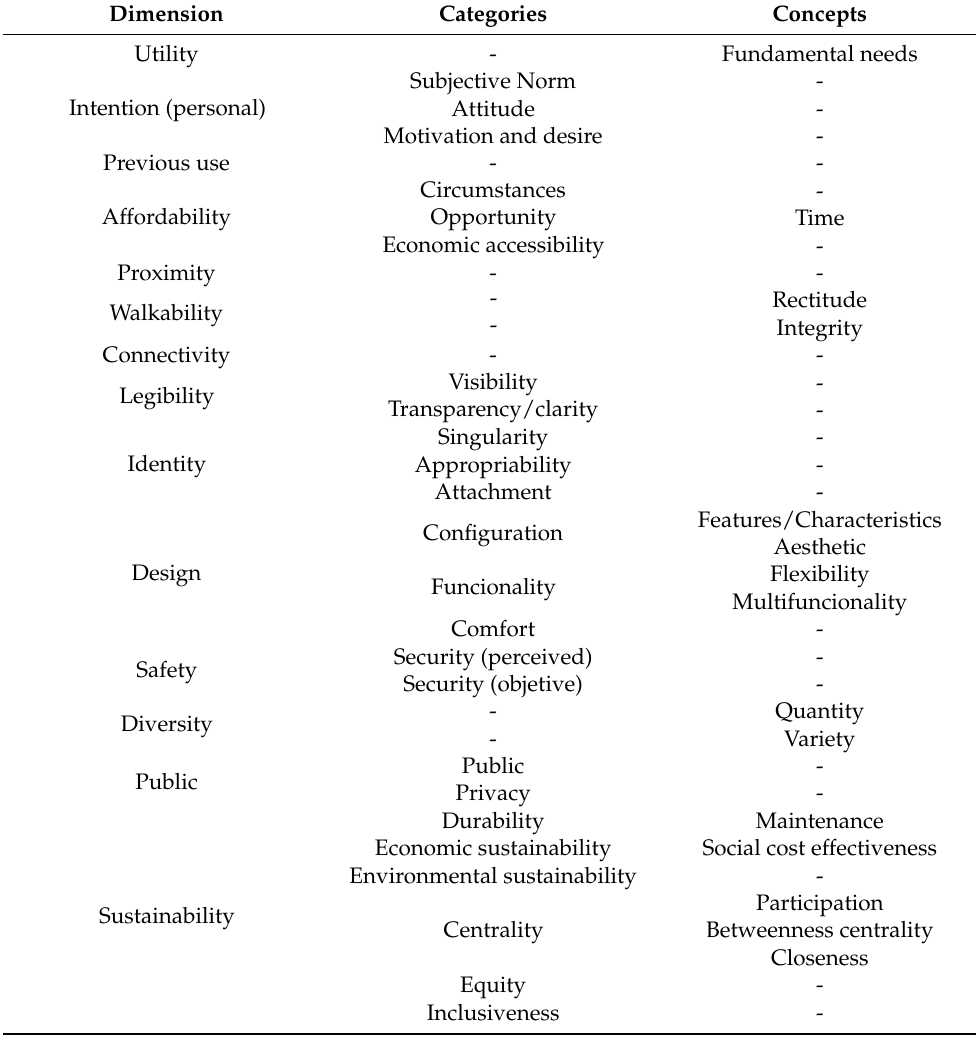
Table 3. Dimensions and categories of community assets for